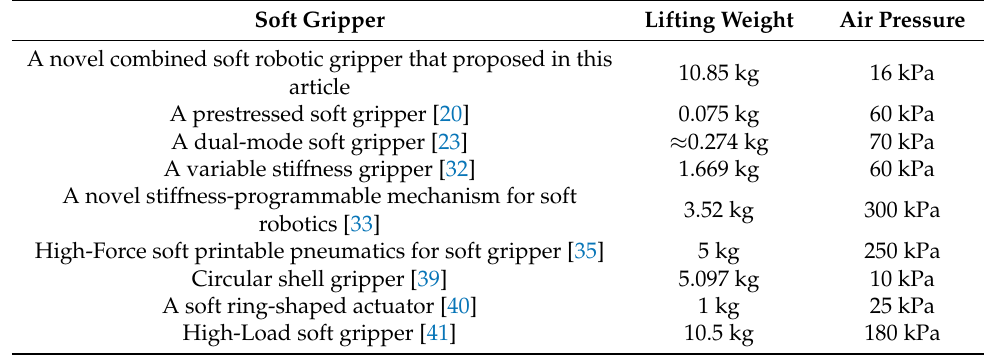
Table 1. Comparison of the maximum load capacity of soft grippers. Soft Gripper Lifting Weight